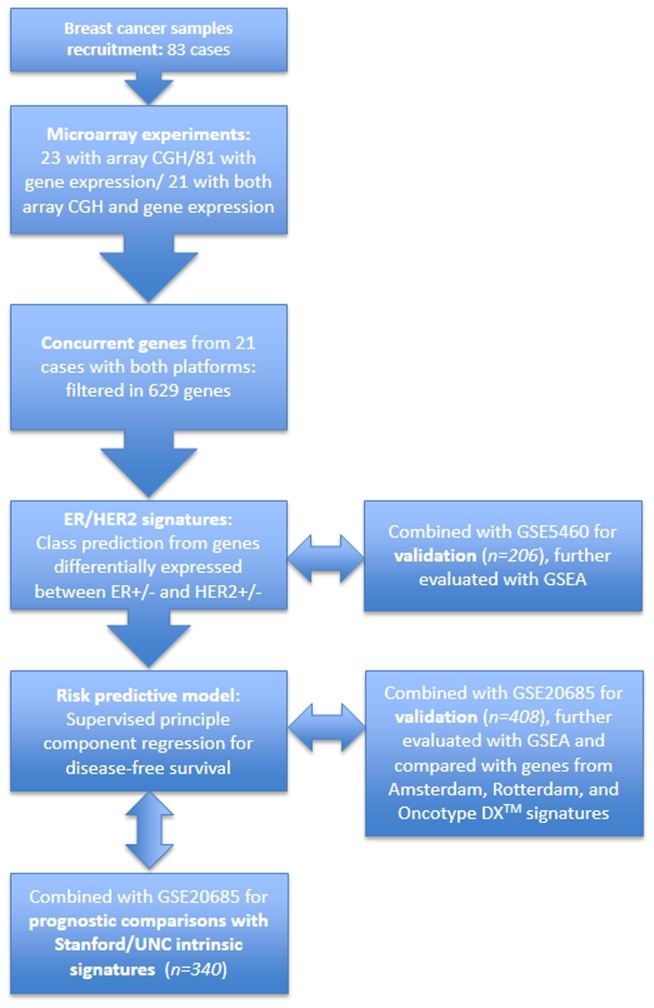
Flow chart of study design (GSEA: Gene set enrichment analysis).